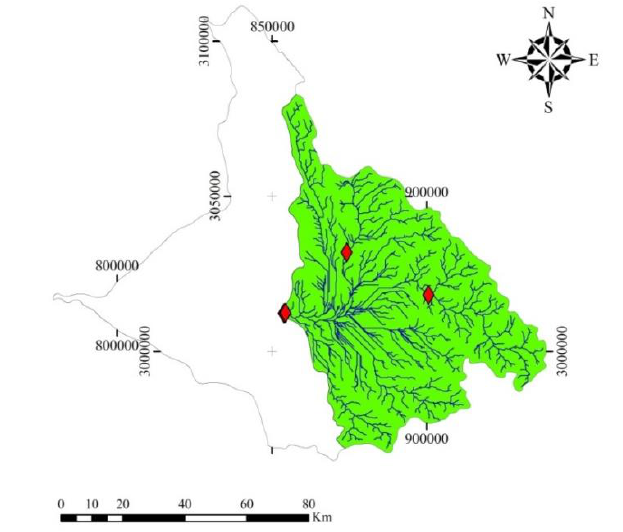
Figure 13. Position of Bampour sub-catchment in Iranshahr catchment